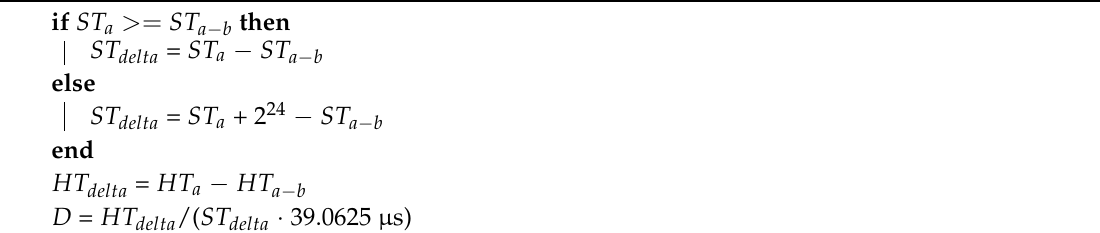
Algorithm 2: More stable drift calculation. The influence of communication jitter is reduced by increasing the time window, using b ∈ N , b >